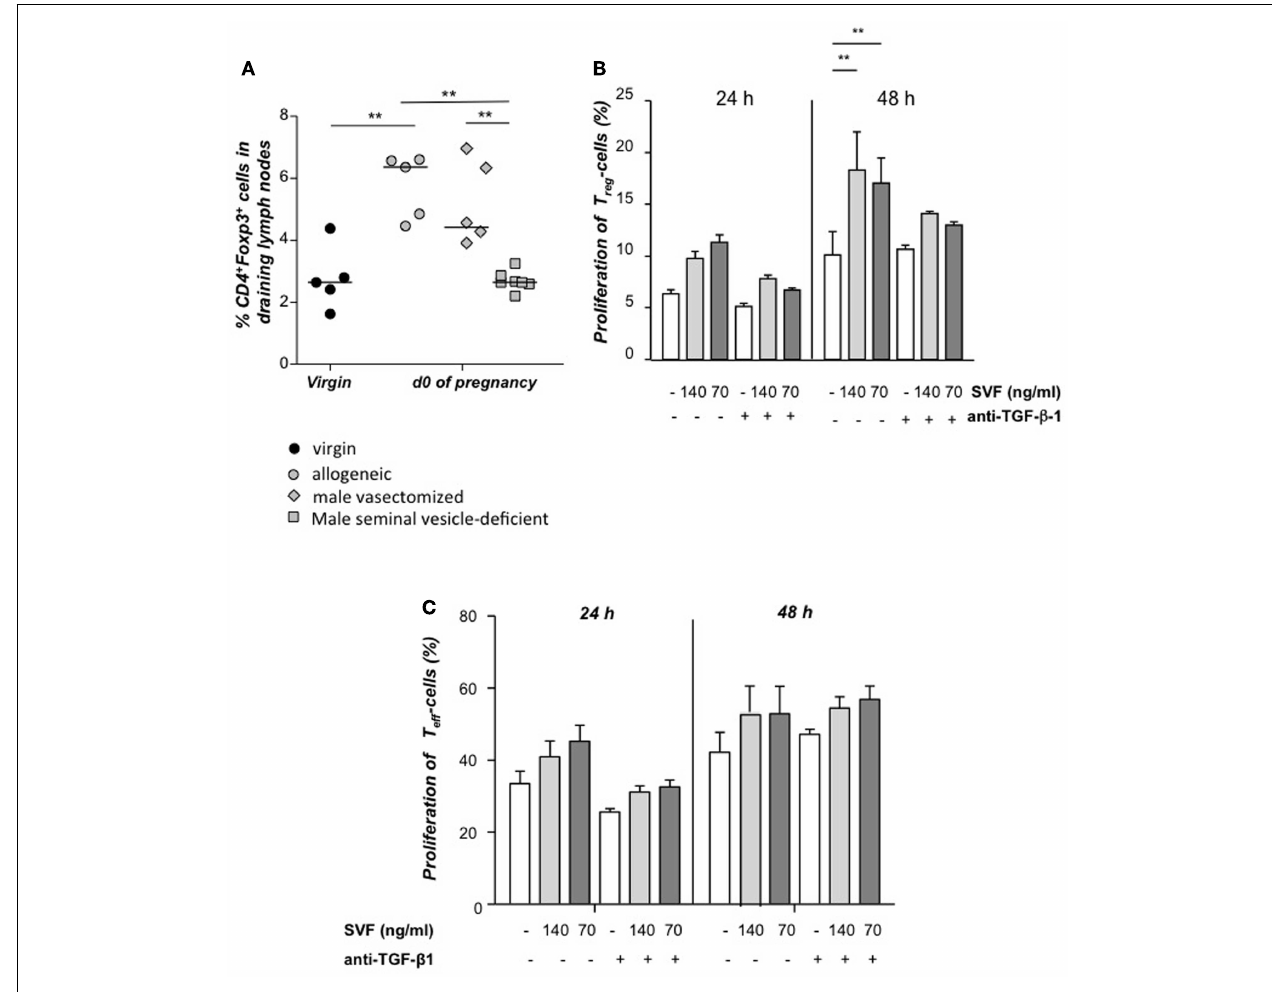
are representative of four experiments and expressed as mean with SEM. Analysis was performed by two-way ANOVA test (** P ≤ 0.01). (C) ConventionalT effector cells were isolated from non-pregnant CBA/J females by magnetic cell sorting, stained with CFSE and cultured with seminal vesicle fluid (SVF) from BALB/c males.TGF- β 1 was blocked with anti-TGF- β 1 antibody, and proliferation ofTreg determined after 24h by using FACScan Calibur. Data are representative of four experiments and expressed as mean with SEM. Analysis was performed by two-way ANOVA test and no statistically significant differences were found among the